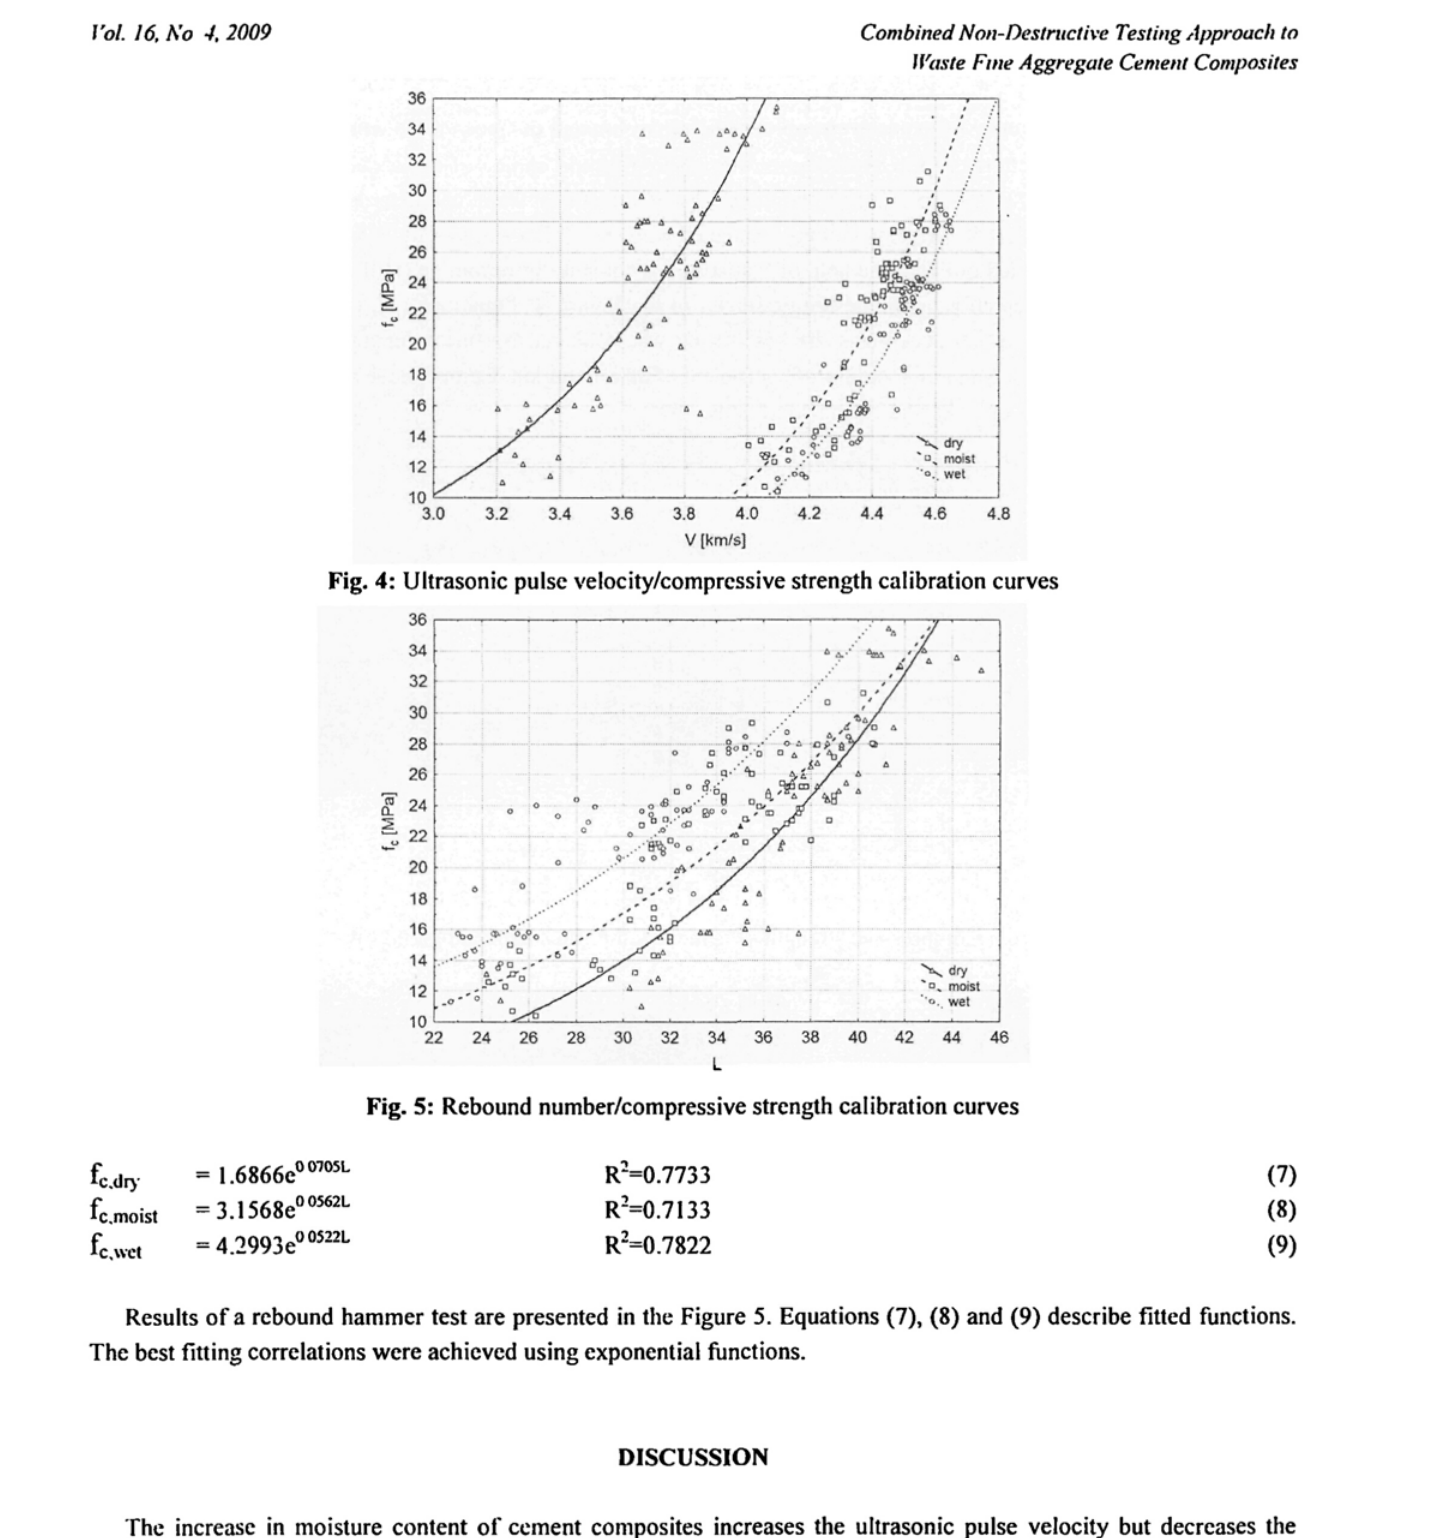
Fig. 4: Ultrasonic pulse velocity/comprcssive strength calibration curves